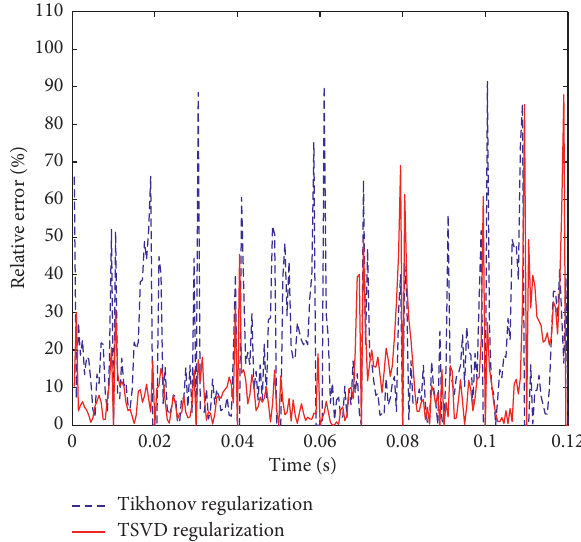
Figure 4: Relative error of sinusoidal load identification at 5% noise level.